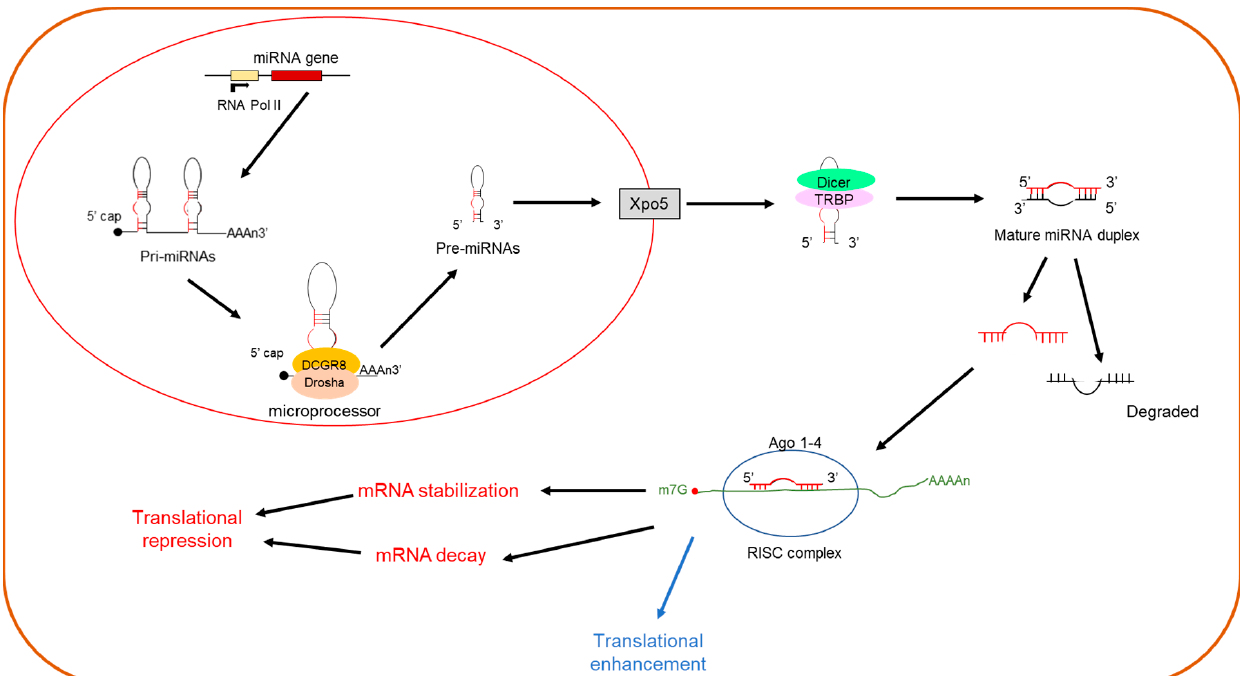
Figure 1. Canonical pathway for miRNA biogenesis.